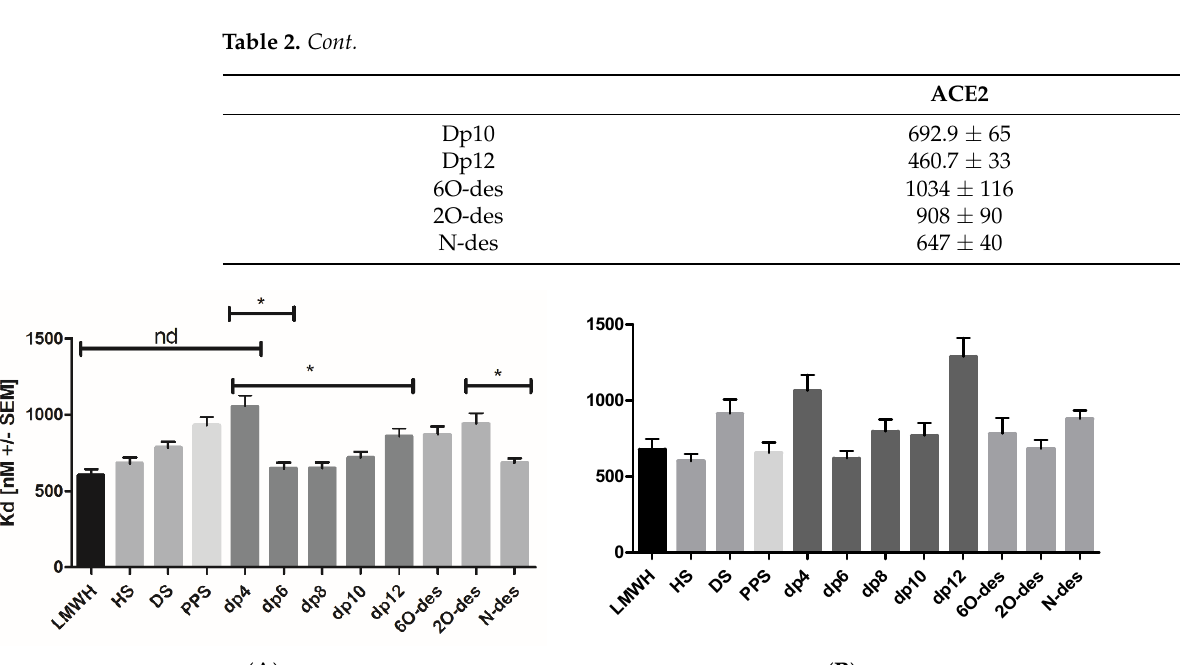
Figure 3. ( A ) Mean Kd values of Spike FL binding to different GAG variants with significant differences (* p < 0.05 was considered as statistically significant) for dp4 to dp6, dp8 dp10; dp6, dp8 to